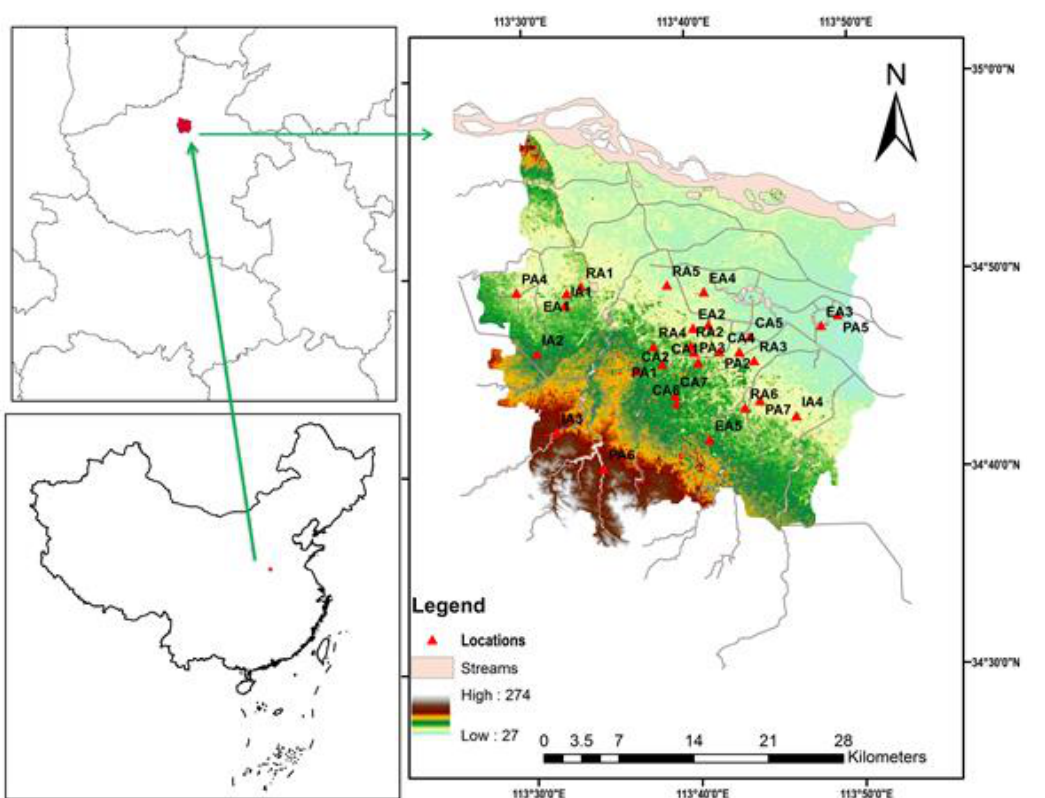
Figure 1. Study Area of Zhengzhou city.